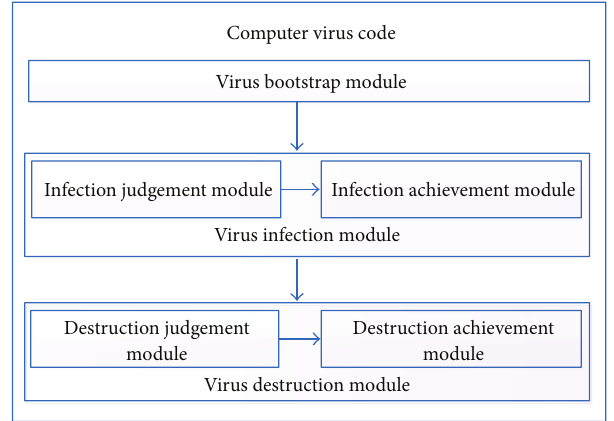
Figure 2: The logic structure of